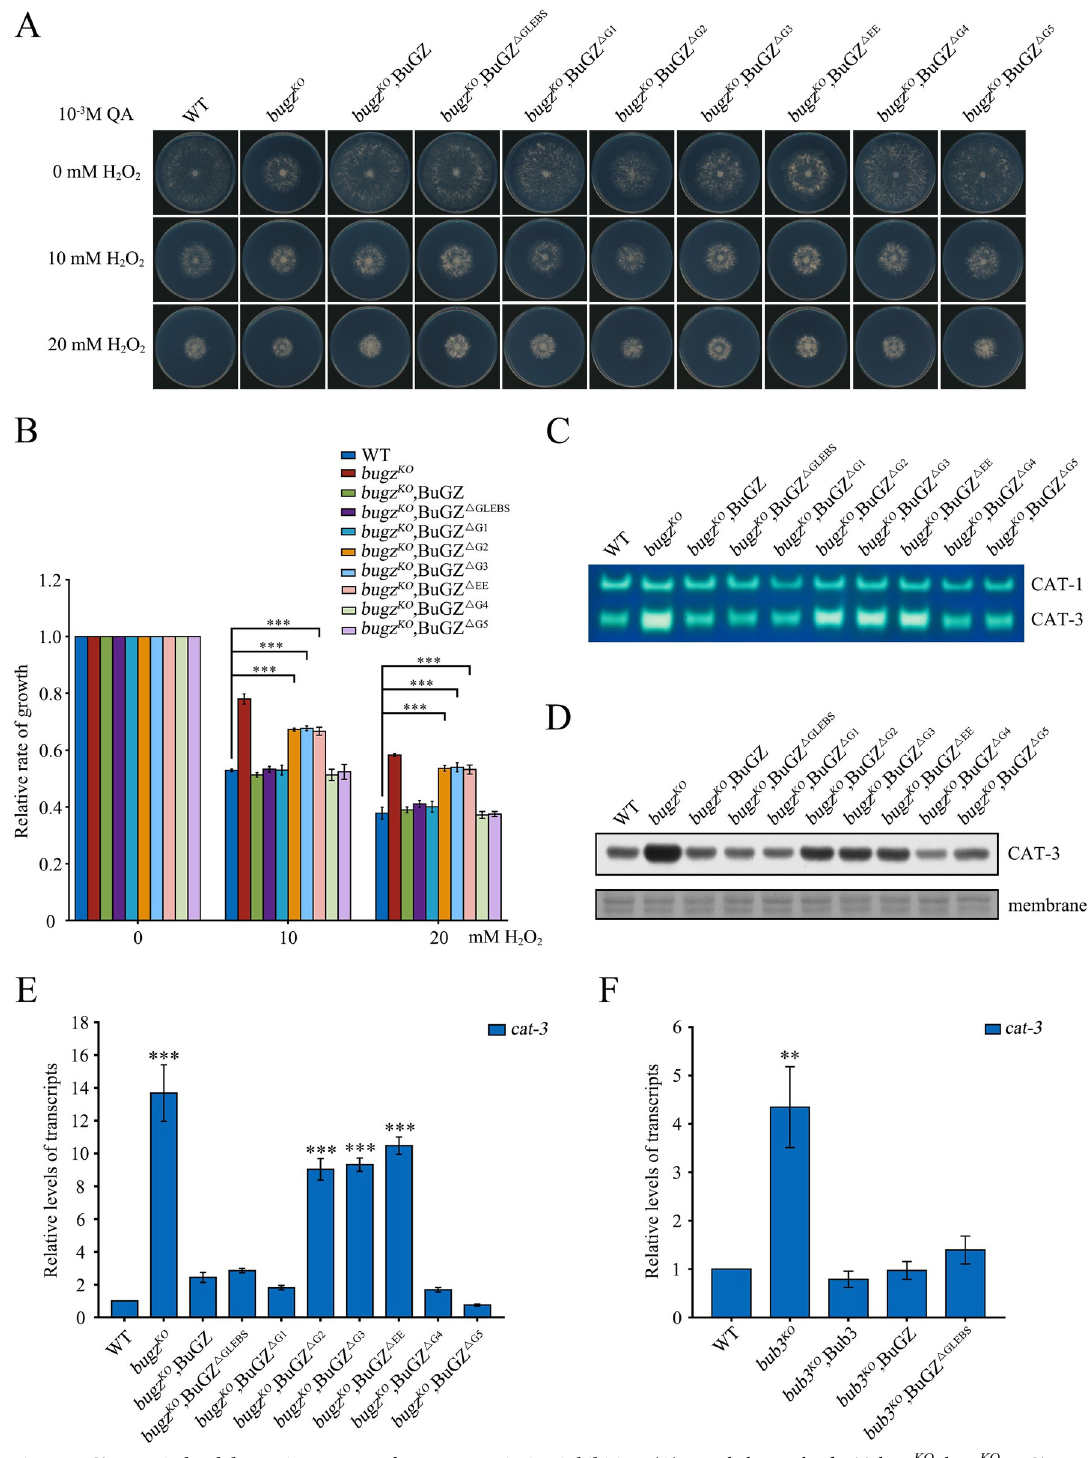
Fig 4. BuGZ protein level determines extent of cat-3 transcription inhibition. (A) Mycelial growth of WT, bugz KO , bugz KO ,BuGZ, bugz KO ,BuGZ Δ GLEBS , bugz KO ,BuGZ Δ G1~ Δ G5 , and bugz KO ,BuGZ Δ EE strains on plates with 0, 10, or 20 mM H 2 O 2 . (B) Quantitation of growth of strains described in panel A relative to WT. (C) In-gel analyses of catalases activities in extracts from WT, bugz KO , bugz KO , BuGZ, bugz KO ,BuGZ Δ GLEBS , bugz KO ,BuGZ Δ G1~ Δ G5 , and bugz KO ,BuGZ Δ EE strains. (D) Western blot analysis of CAT-3 protein in WT, bugz KO , bugz KO ,BuGZ, bugz KO ,BuGZ Δ GLEBS , bugz KO ,BuGZ Δ G1~ Δ G5 , and bugz KO ,BuGZ Δ EE strains. The membranes stained by